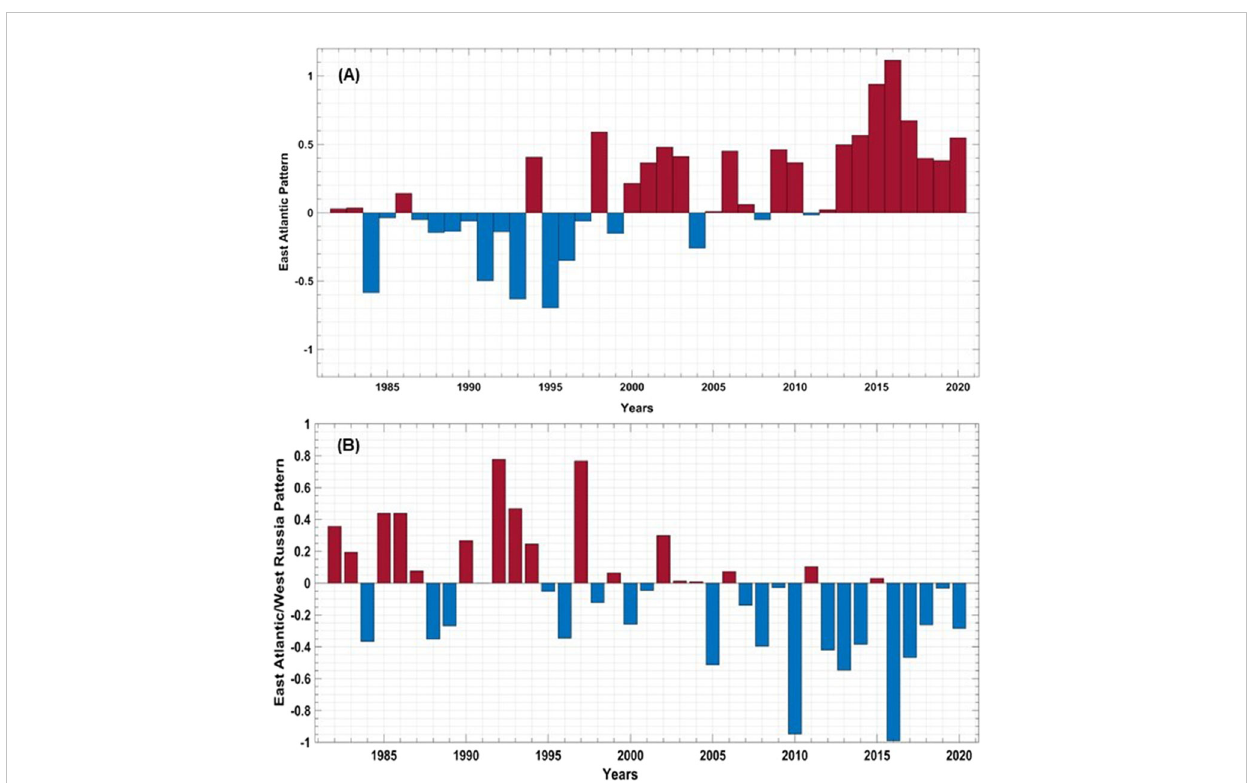
FIGURE 6 The annual time series from 1982 to 2020 of (A) the Eastern Atlantic Pattern (EAP), and (B) the East Atlantic/West Russian Pattern (EATL/WRUS). The red and blue bars refer to the positive and negative phases of the climate indices,